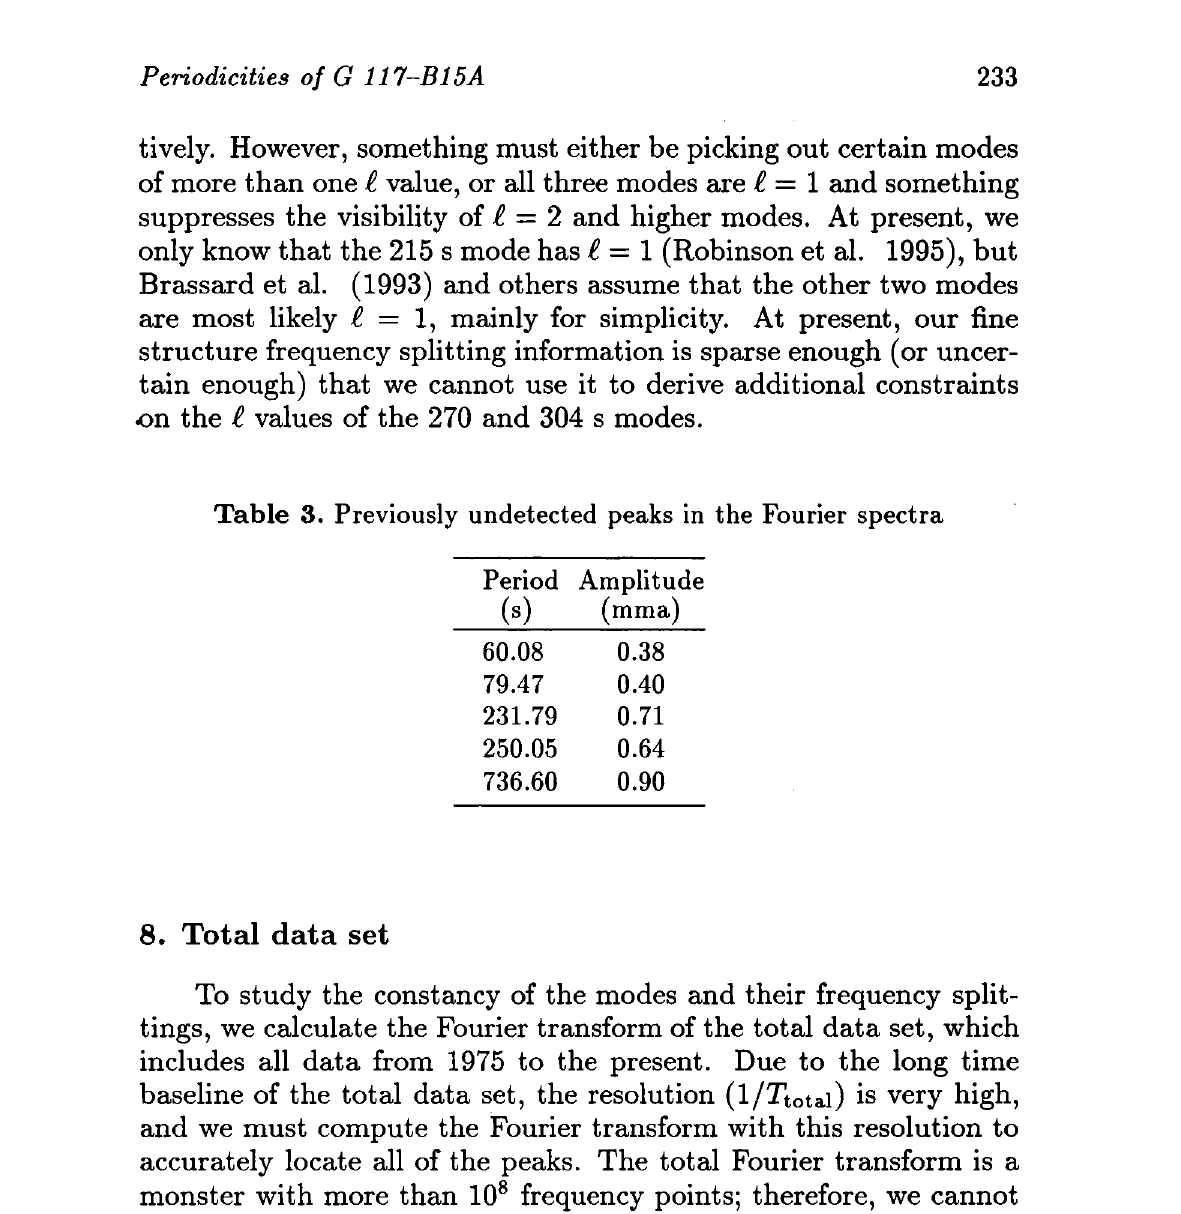
Table 3. Previously undetected peaks in the Fourier spectra